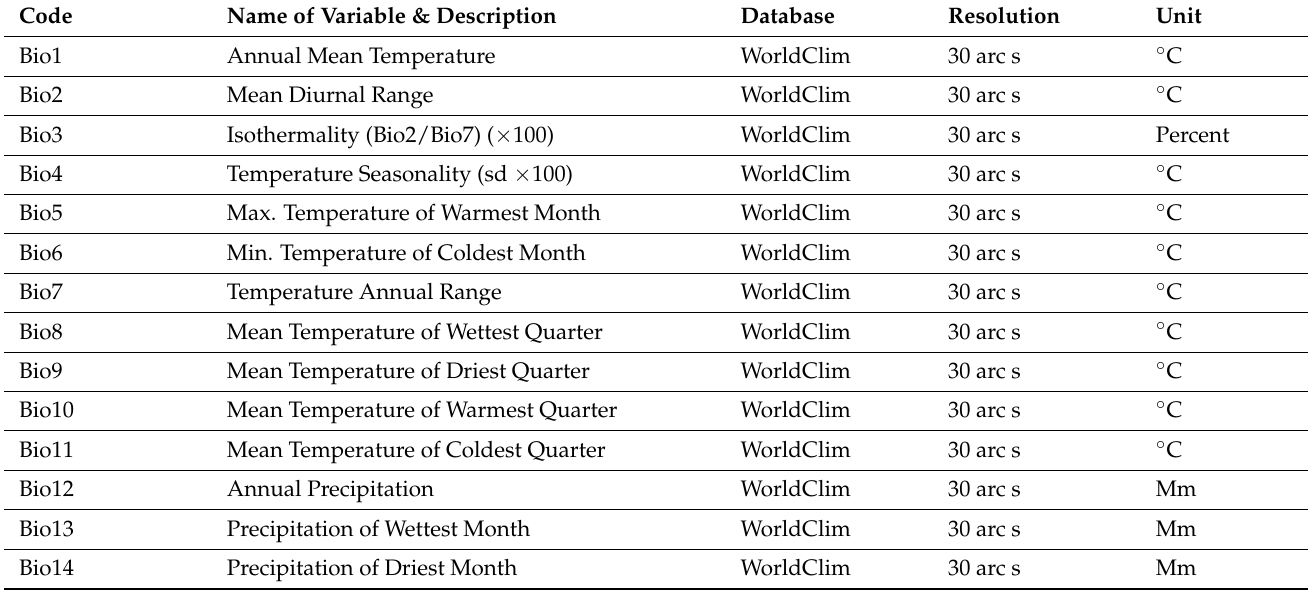
Table 1. The details of environmental predictors employed in MaxEnt SDM of P. gerardiana in the study